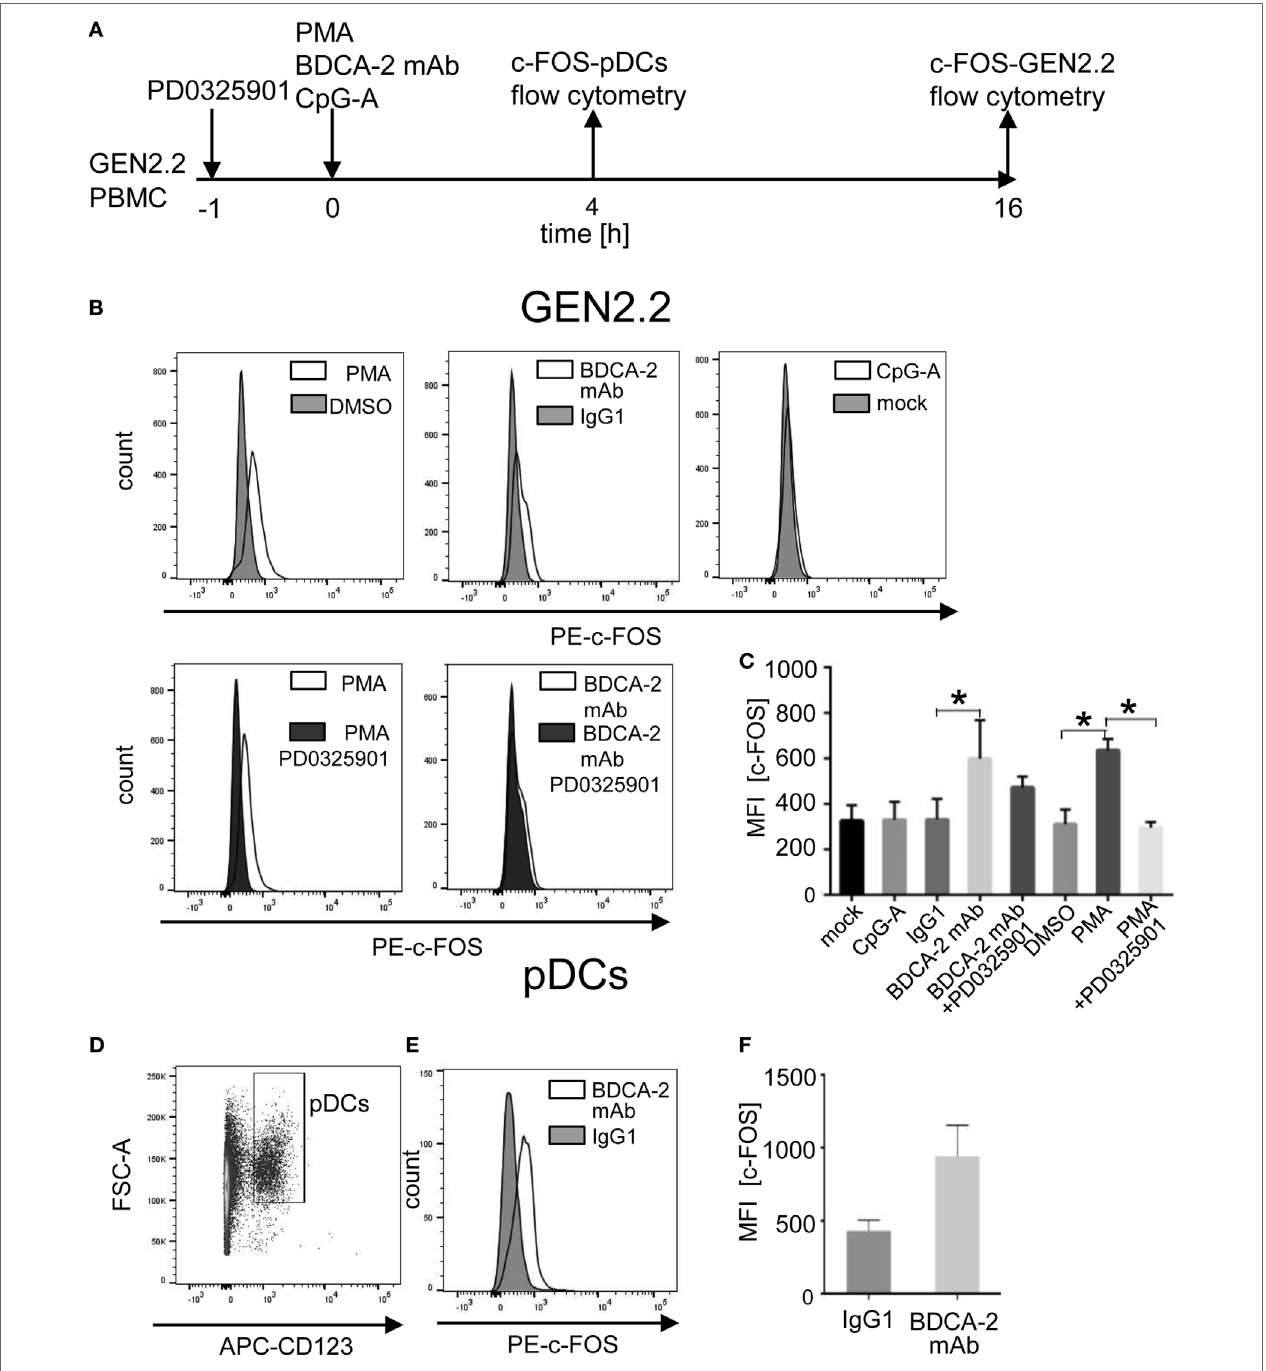
FigUre 11 | Induction of total c-FOS in GEN2.2 cells and primary plasmacytoid dendritic cells (pDCs). (a) Experimental outline. GEN2.2 cells separated from MS-5 feeder cells exposed or not to PD0325901 were stimulated with phorbol myristoyl acetate (PMA), blood dendritic cell antigen 2 (BDCA-2) mAb, or CpG-A for 16 h. Peripheral blood mononuclear cells (PBMCs) of healthy donors were exposed to BDCA-2 mAb or IgG1 isotype Ab and quantity of the total c-FOS in pDCs gated from PBMCs was determined 4 h later. (B) Fluorescence intensity of the total c-FOS in GEN2.2 cells. Viable GEN2.2 cells were gated according to Live/Dead Zombie Green kit, semipermeabilized and stained with PE-conjugated c-FOS (9F6) rabbit mAb. Control light shaded areas show c-FOS in unstimulated PD0325901 mock-treated GEN2.2 cells. Dark shaded areas show c-FOS in PD0325901-treated GEN2.2 cells. Representative result of three independent experiments. (c) The data show mean MFI ± SEM of the total c-FOS in GEN2.2 cells determined in three independent experiments. *, p < 0.05; unpaired, two-tailed t -test. (D) Primary pDCs in PBMCs were gated negatively for Zombie green- (living cells) and FITC-Lin − and positively for APC-CD123 + . (e) c-FOS in semipermeabilized primary pDCs gated from PBMCs stimulated with BDCA-2 mAb or IgG1 isotype for 4 h was stained with PE-c-FOS (9F6) rabbit mAb. Representative result of three independent experiments with PBMCs from different healthy donors. (F) The data show mean MFI ± SEM of the total c-FOS in primary pDCs gated from BDCA-2-stimulated or unstimulated PBMCs determined in three independent experiments in PBMCs of different